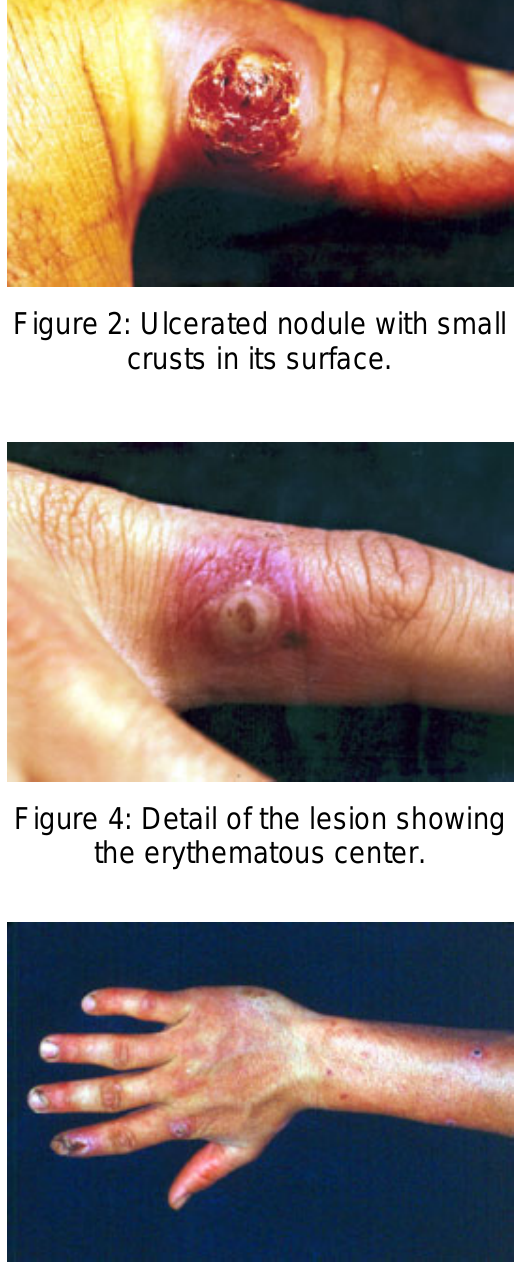
Figure 5: Multiple lesions affecting both hands.